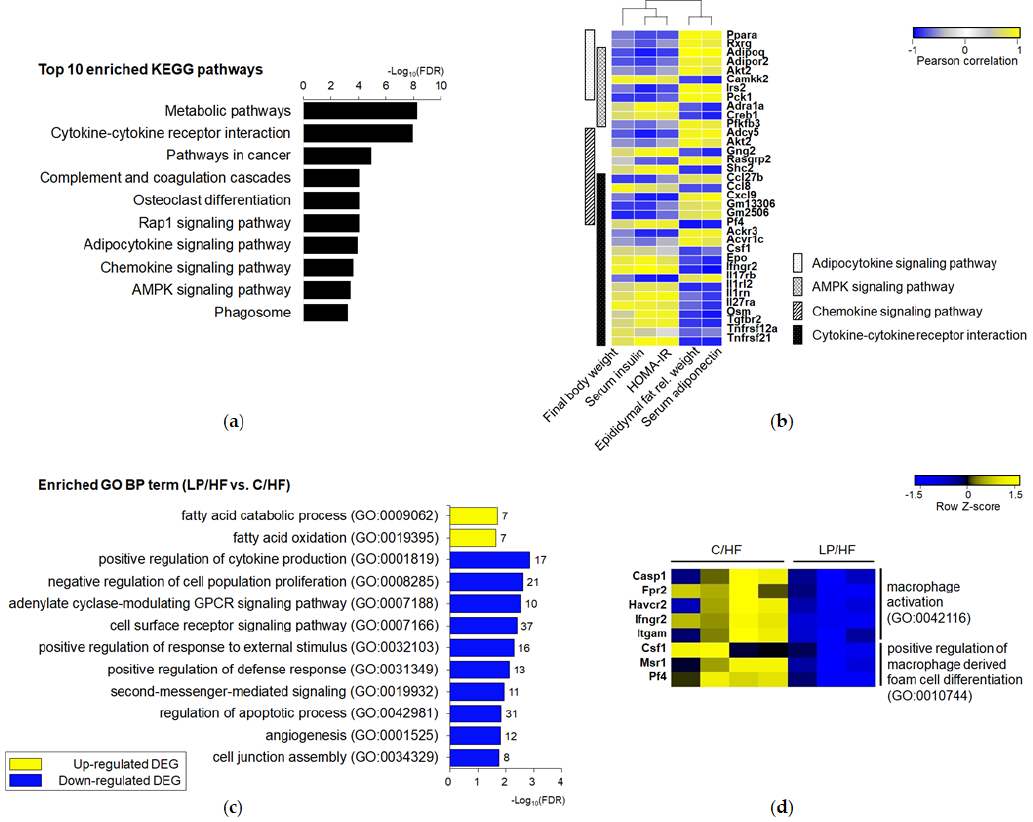
Figure 3. Functional enrichment analysis of the list of di ff erentially expressed genes (DEGs) between LP / HF and C / HF groups. ( a ) The top 10 enriched Kyoto Encyclopedia of Genes and Genomes (KEGG) pathways were selected and sorted by descending order of − log10(FDR). ( b ) Heatmap showing Pearson correlation coefficients between anthropometric and serum biochemical parameters, and expressions of DEGs involved in significantly enriched KEGG pathways associated with insulin resistance and inflammation. Yellow color represents positive correlation and blue color represents negative correlation. ( c ) Gene ontology (GO) annotations of up-regulated (yellow) and down-regulated DEGs (blue). Top 10 enriched unique specific biological process (BP) terms from up-regulated DEGs and all of the unique specific BP terms from down-regulated DEGs were selected and sorted by descending order of –log10(FDR). The number of DEGs associated with the listed GO term is indicated at the edge of each bar. ( d ) Heatmap showing the z-score normalized expressions of DEGs enriched in GO terms related to macrophage. Each cell represents the expression of DEG across di ff erent samples, identified by t -test ( P < 0.05, | fold change | ≥